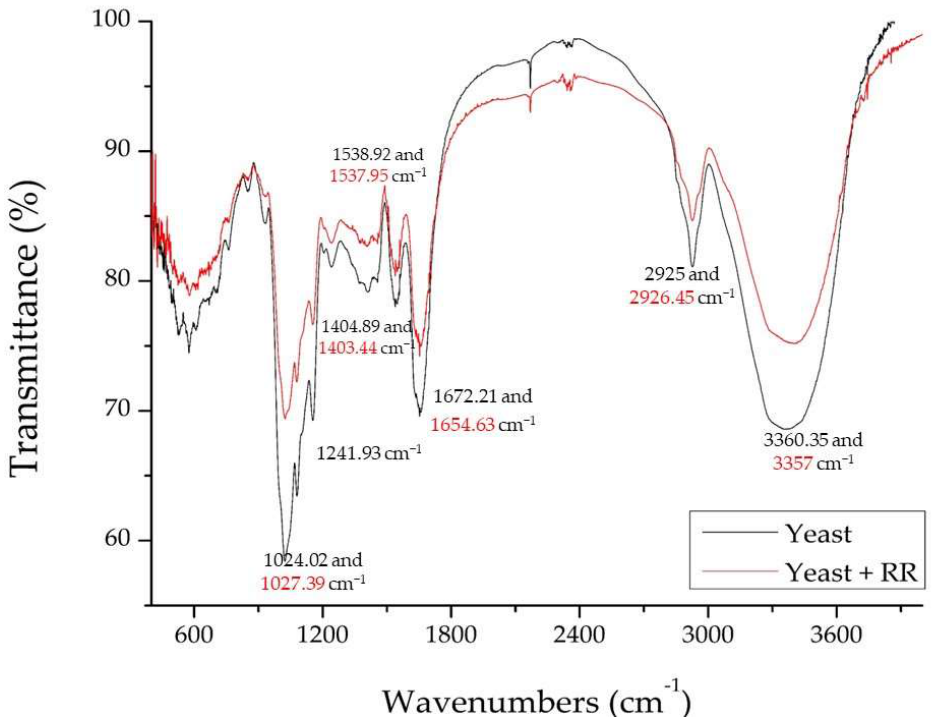
Figure 4. FTIR analysis for lyophilized yeast before and after RR dye adsorption .